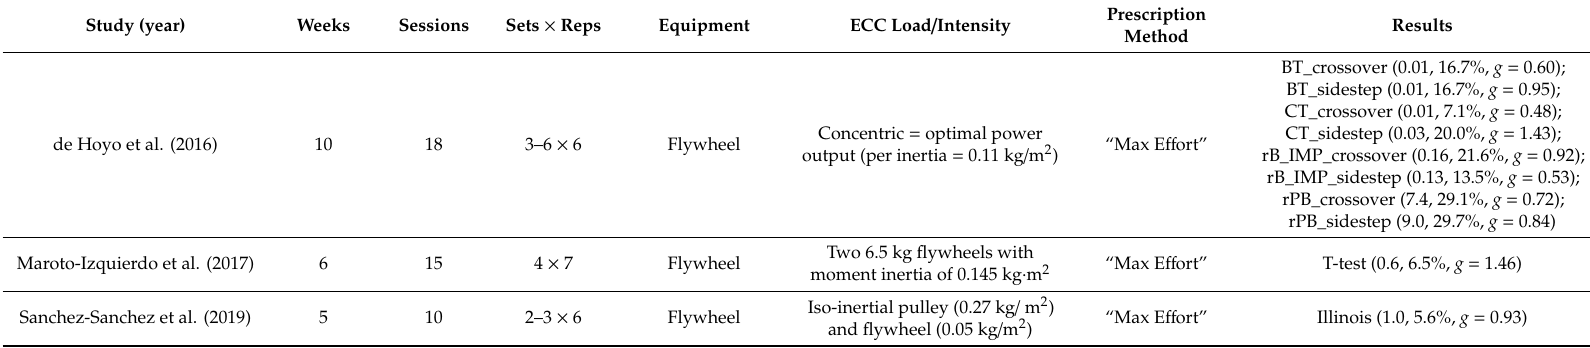
Table 6. Eccentric training intervention characteristics for change of direction